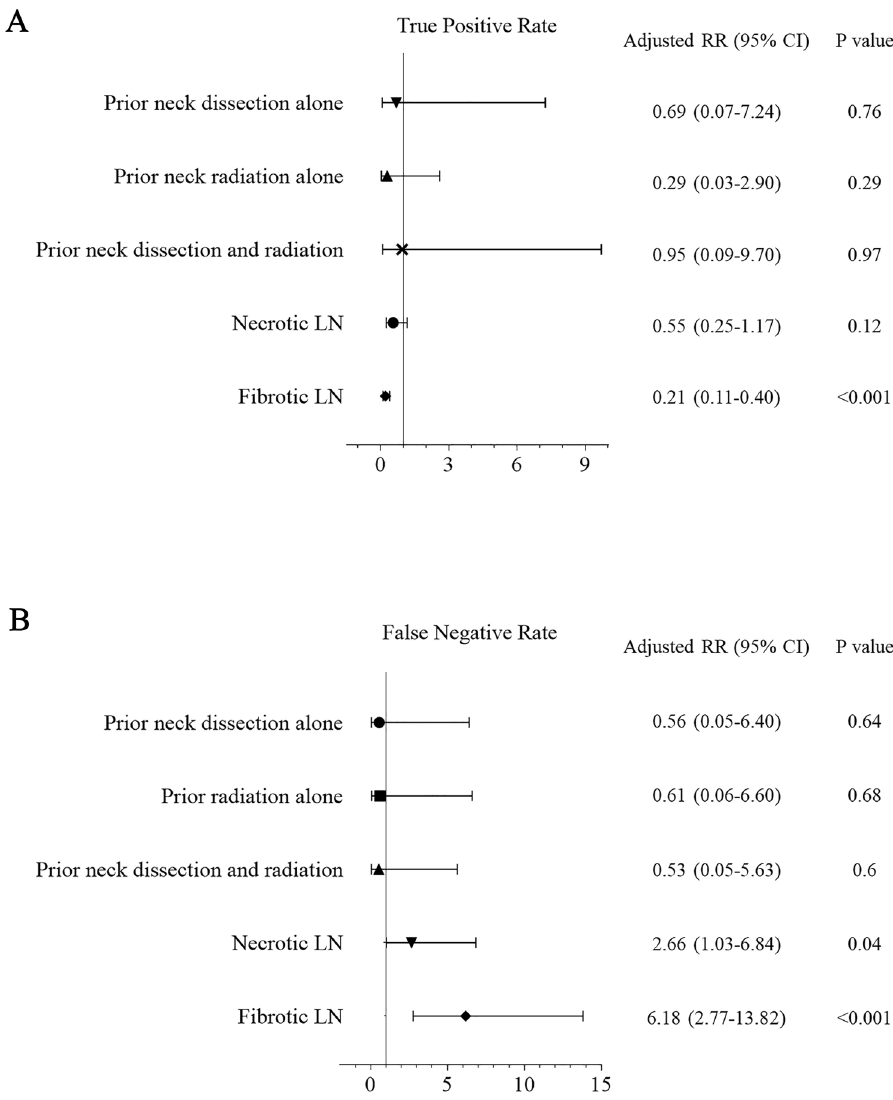
Figure 2. Forest plot of multivariate analysis of possible impacting factors using the logistic regression method in ( A ) true positive rates and ( B ) false negative